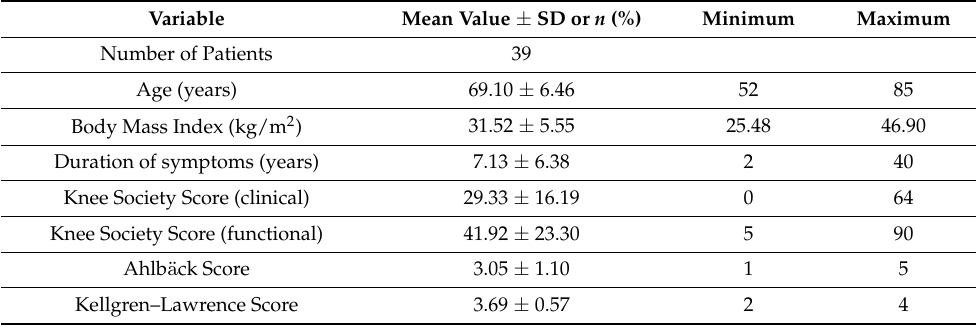
Table 1. Demographic and clinical characteristic of the studied group.